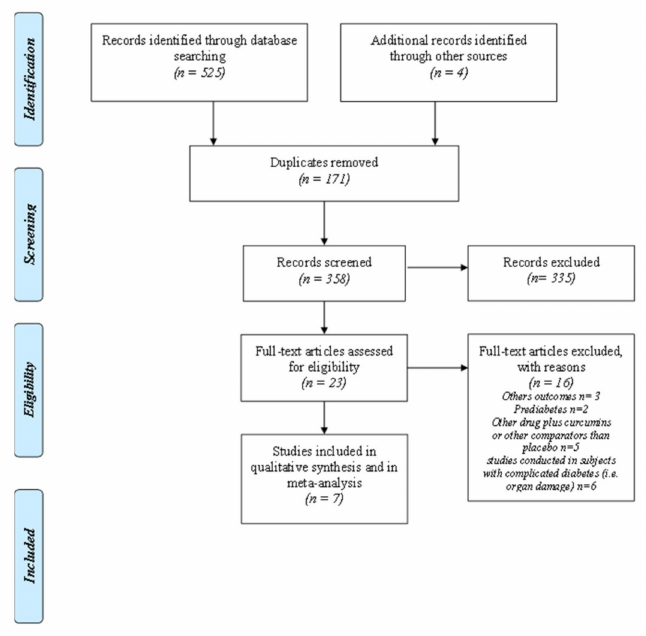
Figure 1. Prisma